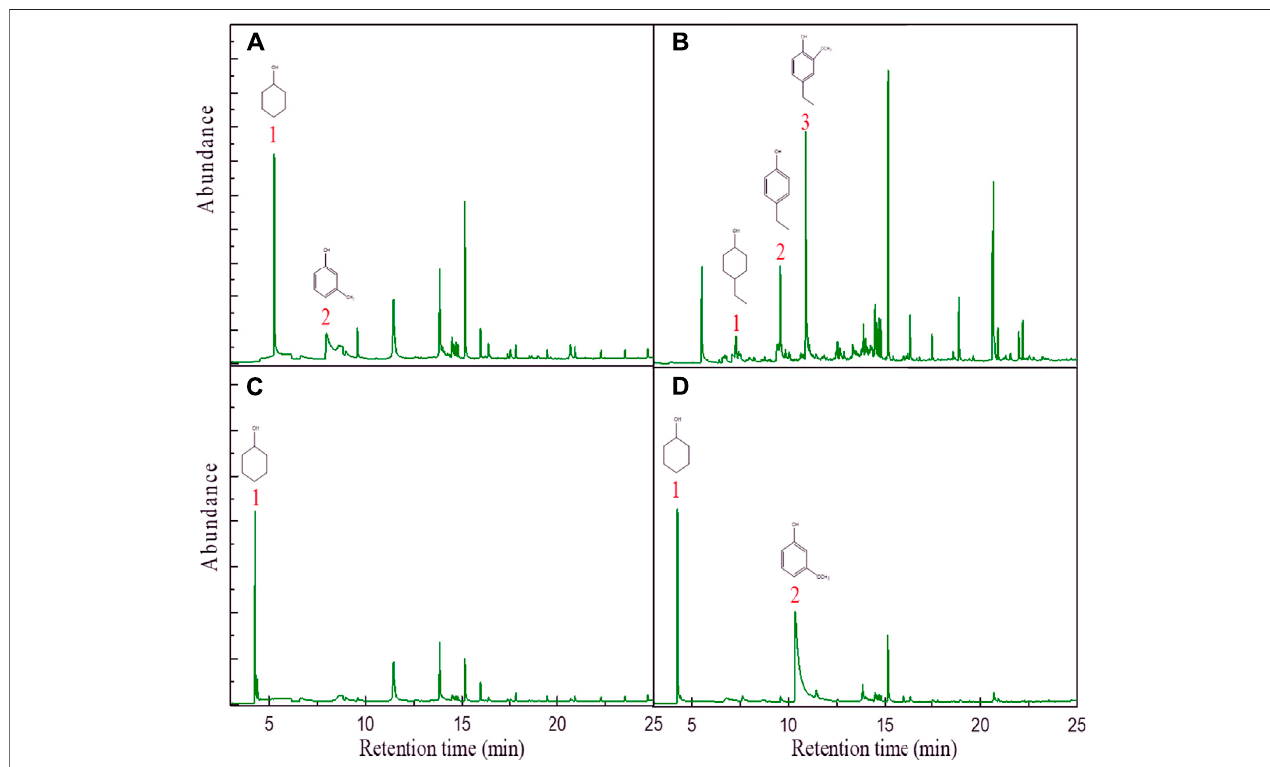
FIGURE 7 | The GC-MS data graph of (A) m-cresol, (B) ethyl-guaiacol, (C) phenol, and (D) 3-methoxyphenol. Reaction conditions: 0.5 g of 10Ni-10Mn/Nb 2 O 5 , 200 ° C, 5 h, and 1 MPa N 2